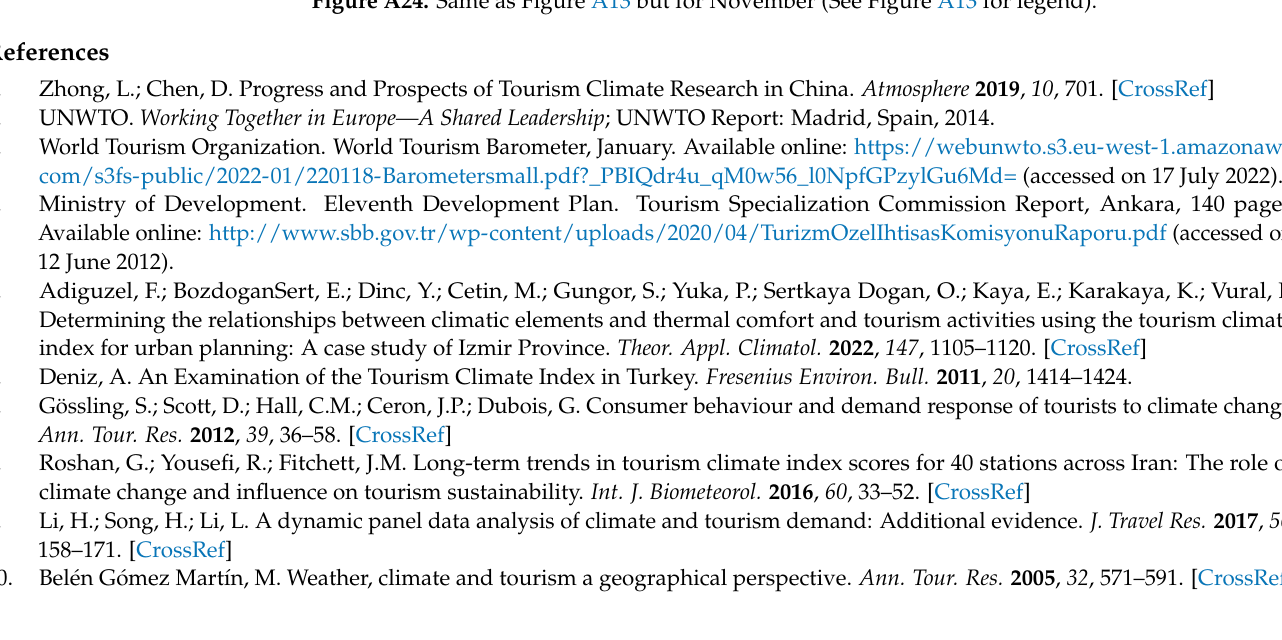
Figure A24. Same as Figure A13 but for November (See Figure A13 for